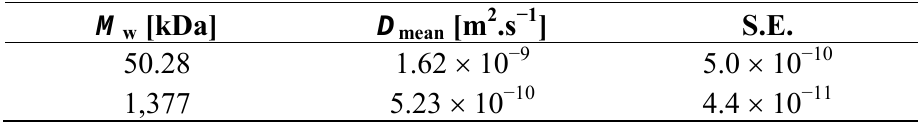
Table 2. The comparison of the mean mutual diffusion coefficients (Dmean) of hyaluronan for two molar mass. (The standard errors estimated for confidence interval at the level 95% was computed for 5 measurements of the same